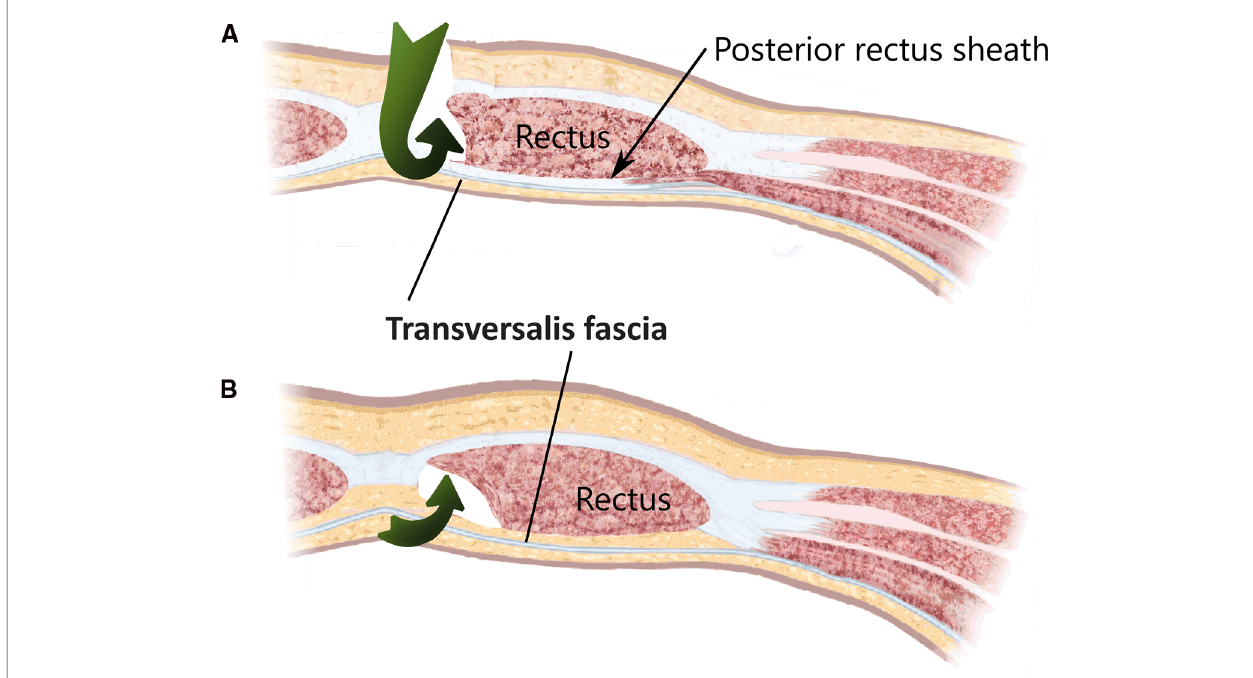
FIGURE 4 | The surgical access (green arrows) of a total extraperitonal hernioplasty through the layers of the ventral abdominal wall are depicted ( A ) cranial and ( B ) caudal of the arcuate area. The transversalis fascia passes the posterior rectus sheath dorsally and continues beyond the arcuate area and separates the musculoaponeurotic structures from the visceral